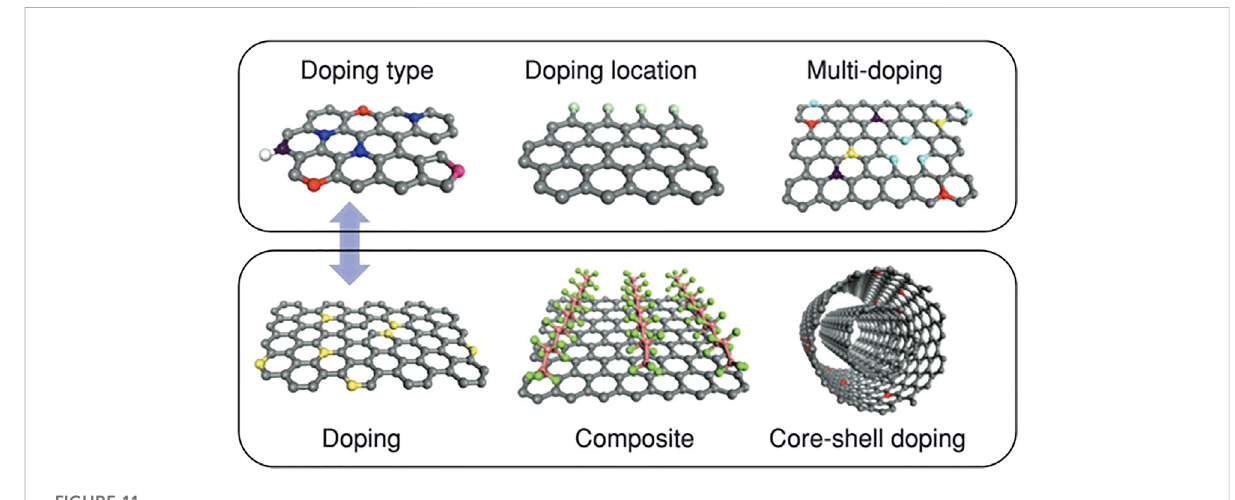
FIGURE 11 Illustration of different doping designs in graphene (Hu et al.,